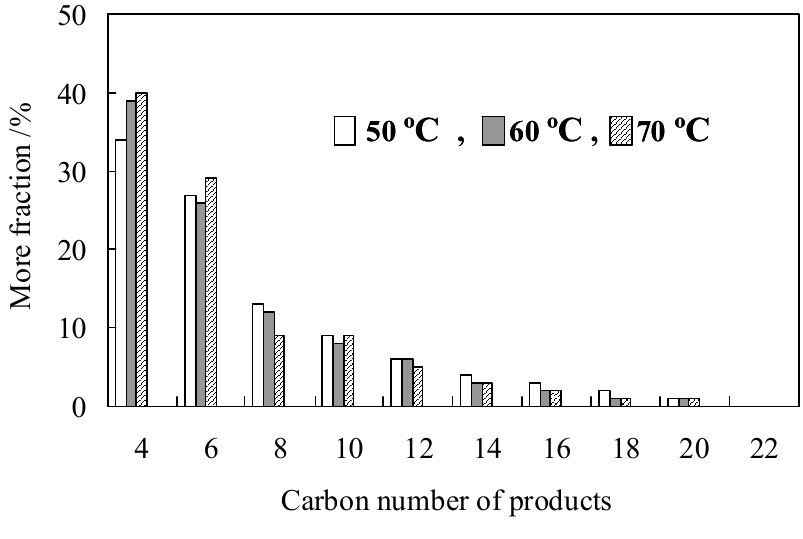
Figure 4. Distribution of products from ethylene oligomerization at 50–70 °C using L3 /Ni 2+ -Mica procatalyst. Reaction conditions are the same as in Table 1.